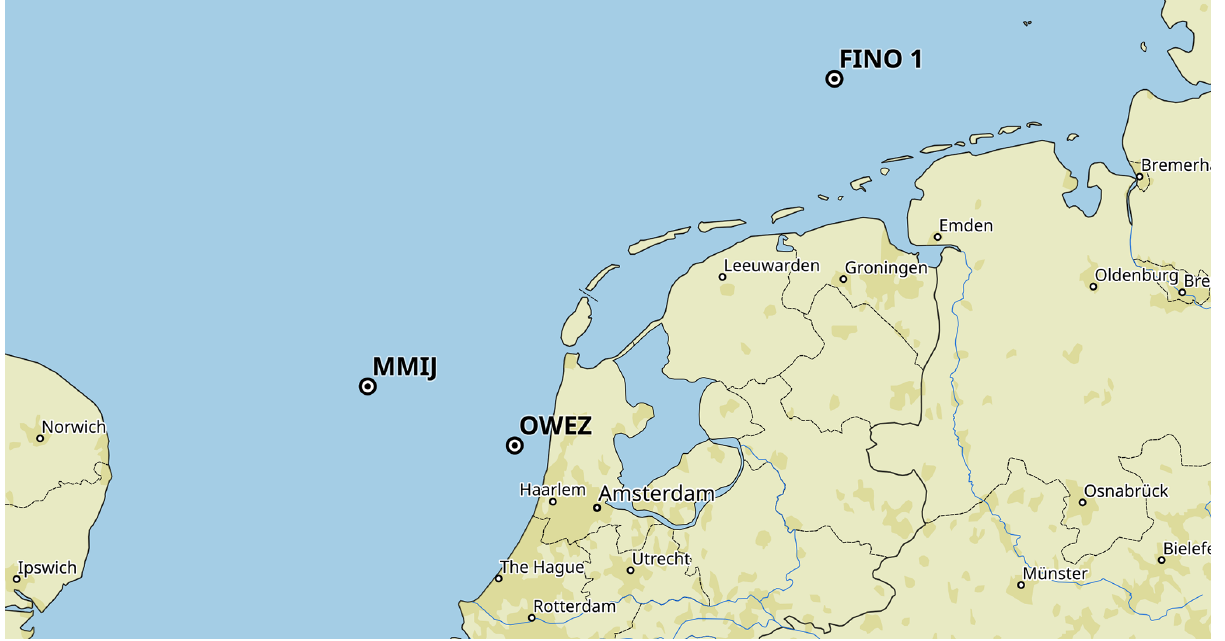
Figure 1. A map with the location of the three offshore met masts from which data were analyzed: OWEZ, MMIJ, and